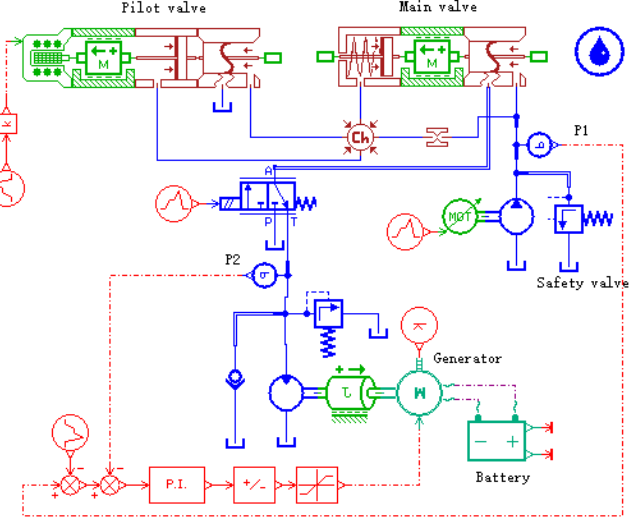
Figure 13. The system schematic diagram.